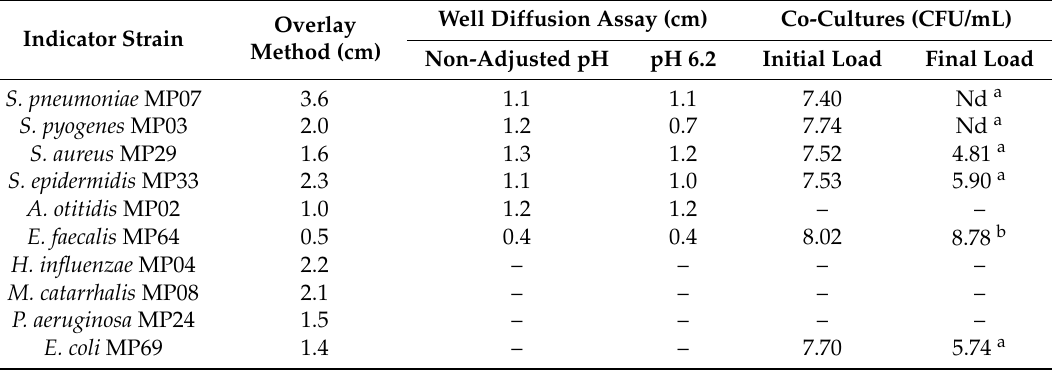
Table 2. Final pH and production of organic acids (mg/mL; mean ± SD) in an MRS broth by L. salivarius